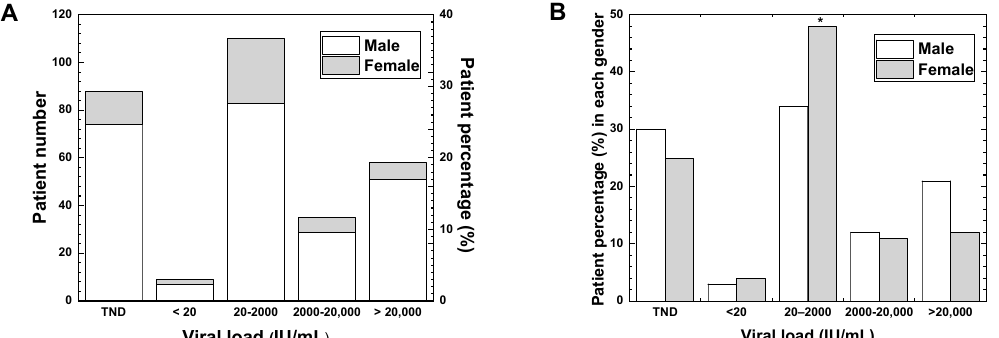
Figure 1. ( A ) Levels of hepatitis B virus (HBV) DNA in plasma among the hepatitis B surface antigen (HbsAg)-positive patients. Each column represents the number (left y axis) and percentage (right y axis) of HBV patients (open, male; shaded, female) at each range of viral loads. The percentage of the HBV patients was calculated as follows: % = (Male + Female patient number at each viral load range) X100 / 300 ( = total patient number of HBV samples). The highest number of patients was in the viral load range of 20–2000 IU / mL. Among 300 patients tested for the viral loads, 244 patients (81.3%) were male and 56 patients (18.7%) were female. ( B ) Percentage of HBV patients at each viral load range in each gender (open, male; shaded, female). The percentage of patients with viral loads of 20–2000 IU / mL was highest in both males and females, and significantly higher in females (48.2%) than in males (34.0%) (* p < 0.05, χ 2 test). The percentage of the HBV patients in each gender was calculated as follows: % = (Patient number at each viral load range in males or females) X100 / [244 samples (males) or 56 samples (females)]. HBV DNA was quantified by real-time polymerase chain reaction (PCR) using the COBAS ® AmpliPrep / COBAS ® TaqMan ® System (Roche Diagnostic, Pleasanton, NJ, USA). The linear range of the standard curve was 20–1.7 × 10 8 IU / mL; the HBV DNA levels less than 20 IU / mL were described as < 20 IU / mL. When HBV DNA was undetectable, it was described as the target not detected